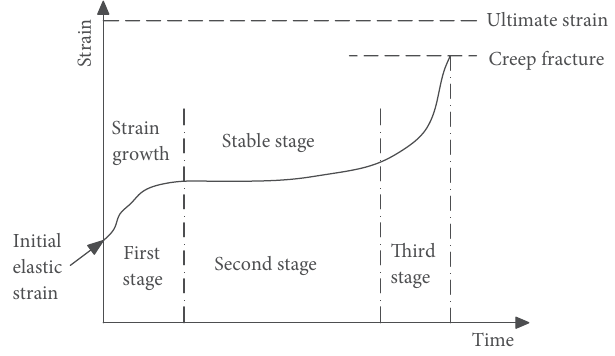
Figure 4: Typical creep curve of the FRP